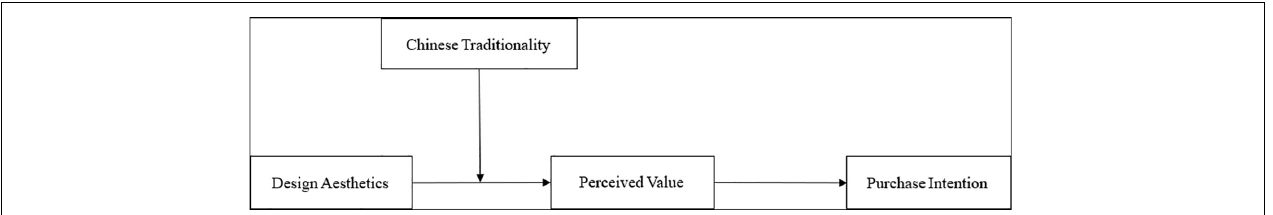
FIGURE 1 | Hypothesized conceptual